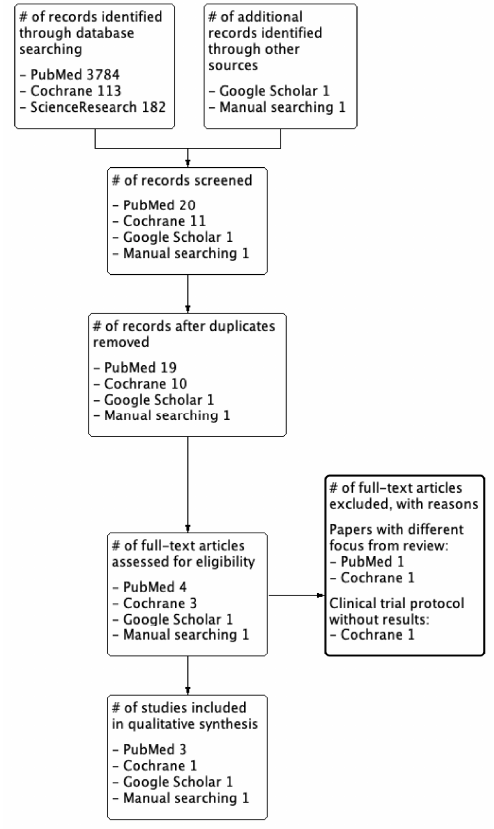
Figure 1. PRISMA graph detailing search results